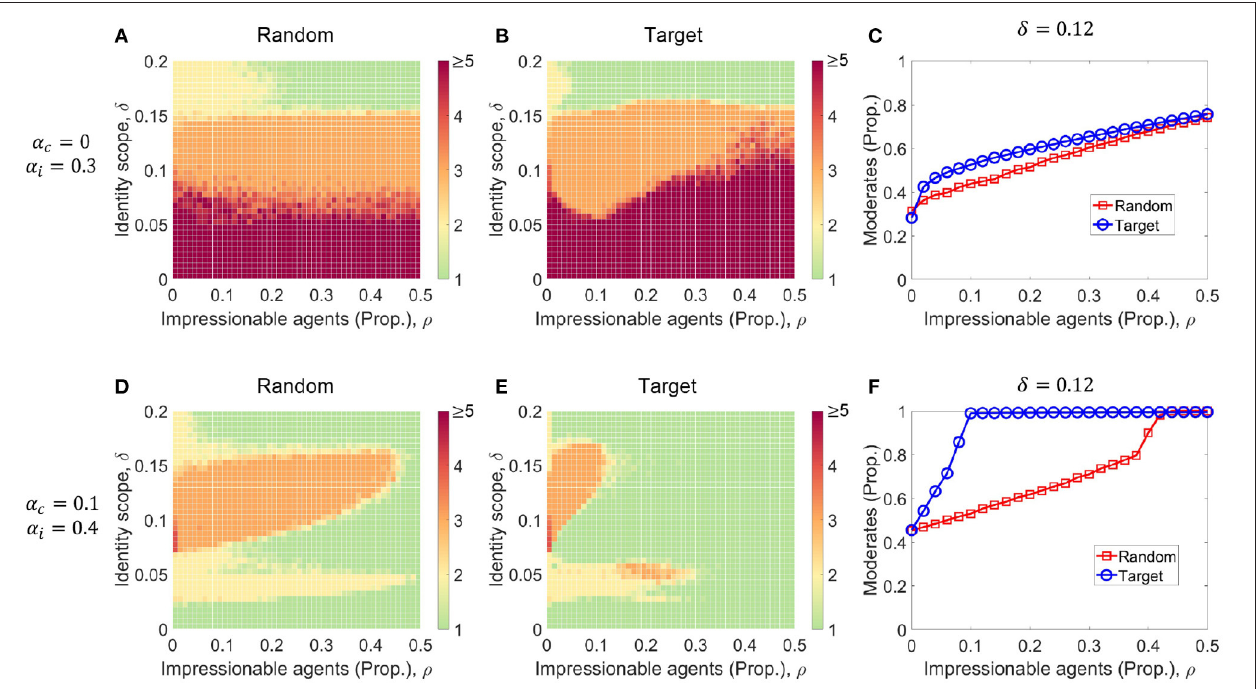
FIGURE 7 | Simulation results on heterogeneous populations. We consider the impact of impressionable individuals under two different situations: (A–C) α c = 0, α i = 0.3 and (D–F) α c = 0.1, α i = 0.4. (A,D) Shown is the number of opinion clusters under different combinations of identity scope ( δ ) and the proportion of impressionable agents ( ρ ), when impressionable agents are randomly selected (Random selection). (B,E) Shown is the phase diagram when agents with a large degree are preferentially selected as impressionable ones (Target selection). (C,F) The proportion of moderates is presented as a function of ρ under the two selection strategies. Compared to random selection, target selection could promote the efficiency of depolarization. However, the difference between the two strategies is limited when α c = 0, while it is large when α c 6= 0. Parameters: µ 1 = 0.7, µ 2 = 0.7. In addition, (C,F) δ =